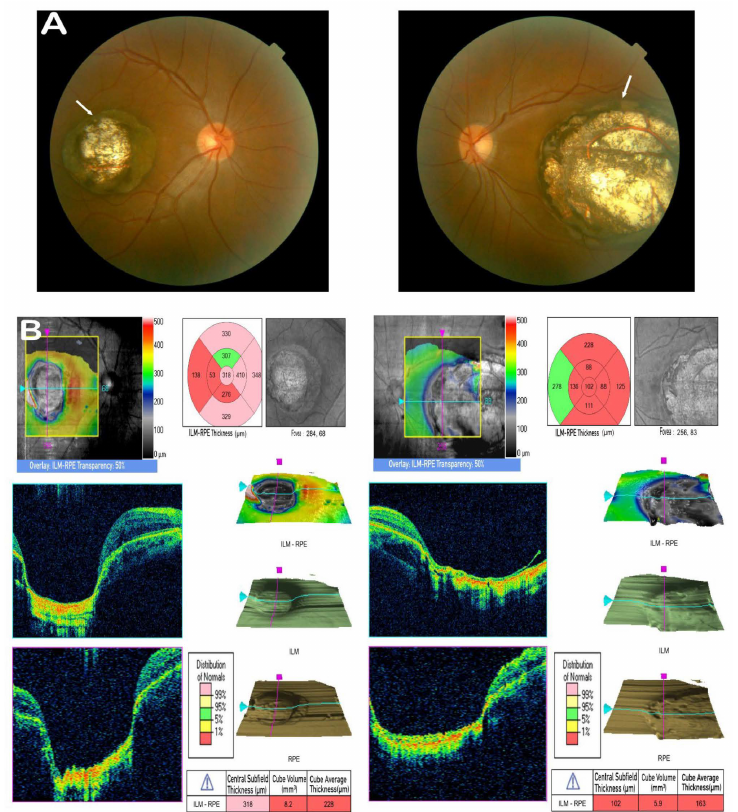
Figure 2. Clinical observations. ( A ) Fundus photograph of the proband (II:3) exhibiting prominent bilateral atrophy in the macula (white arrows); the atrophy presents well-circumscribed borders, total chorioretinal maldevelopment with a white appearance, and increased backscatter around the lesion due to the bare sclera. ( B ) OCT scan of the proband (II:3) showing a cup-shaped lesion with the complete absence of retina and choroid. There is a sharp margin, with significant excavation in the foveal region of both